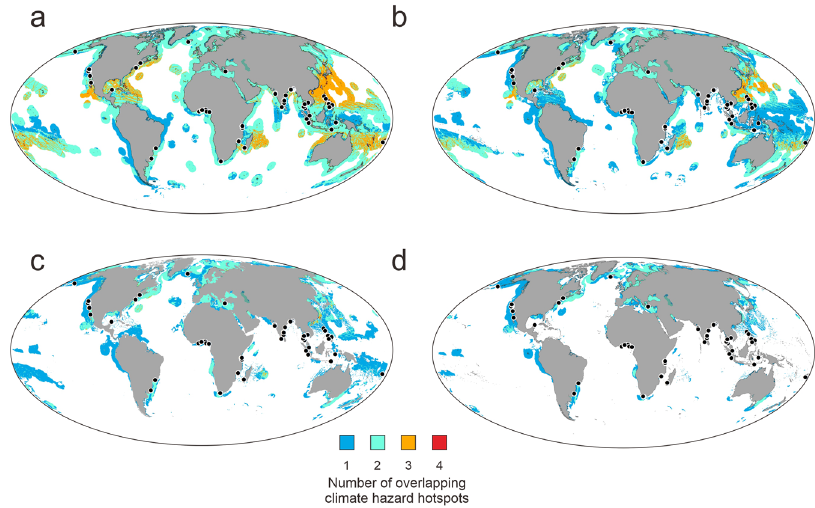
Fig. 3 Spatial overlap of the geographical locations of adaptation responses and climate change hazards. Correspondence of climate change adaptation responses ( n = 281) with regions of increasing cumulative exposure to the four climate change hazards (rates of change in sea-surface temperature, cumulative intensity of marine heatwaves, frequency of tropical storms, and intensity of associated storm surges) calculated for their respective ( a ) 25th, ( b ) 50th, ( c ) 75th, and ( d ) 90th percentiles (the latter representing the climate hazard hotspots). Colors indicate the number of overlapping hazards in a given location. Black dots correspond to the location of the adaptation responses. The maps were created using ArcMap